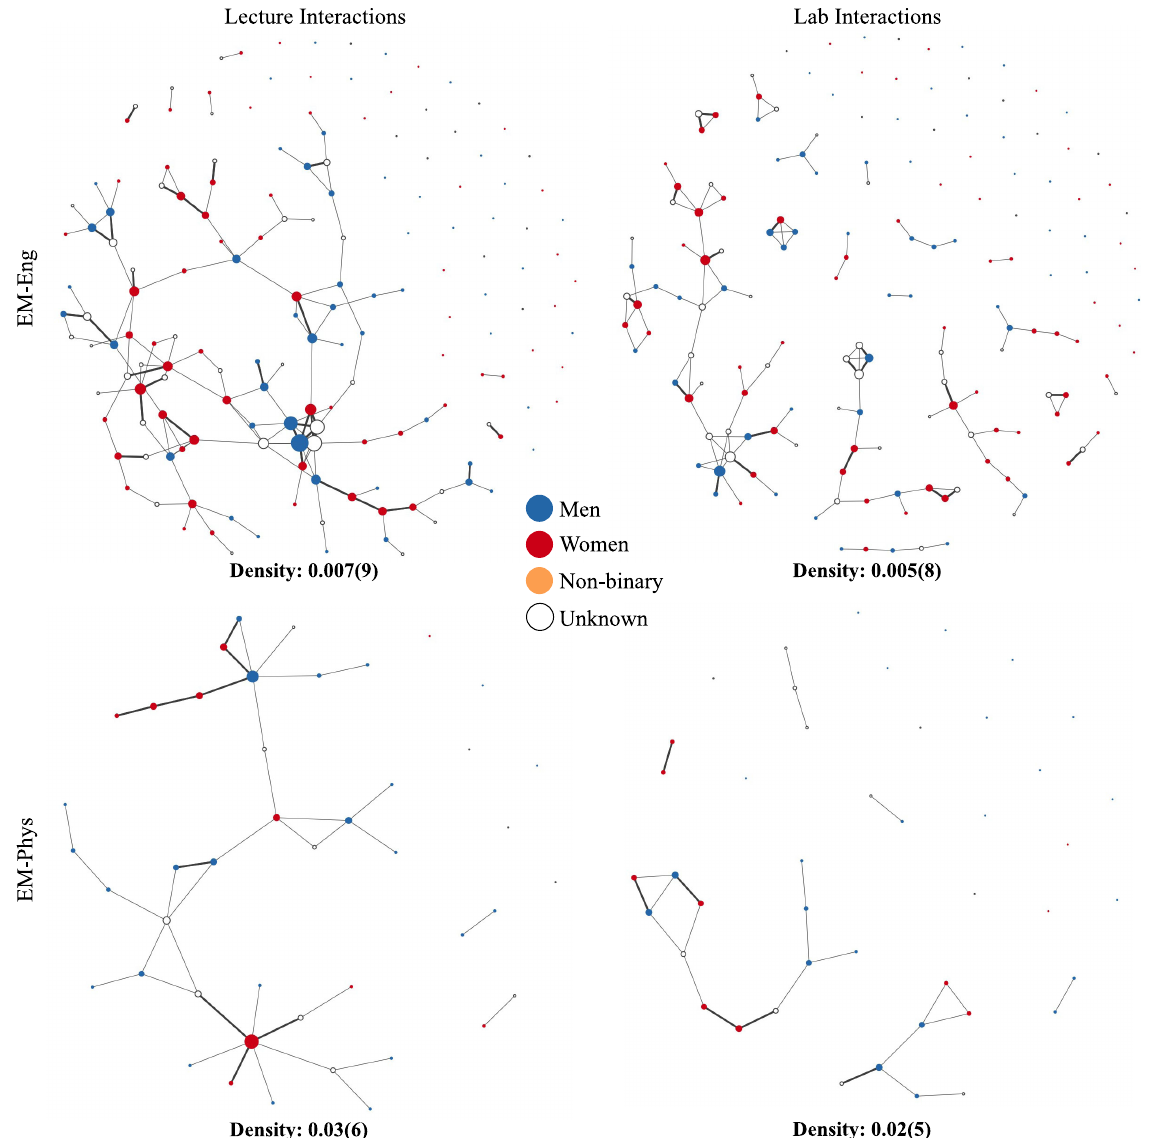
FIG. 3. Diagrams and densities of interaction networks for EM-Eng and EM-Phys. Nodes are colored by gender and sized proportional to total degree (number of adjacent edges). Thick edges represent reciprocal edges (students A and B both reported interacting with one another) and thin edges represent one-way edges (student A reported interacting with student B, but student B did not report interacting with student A). Densities are the proportion of observed to possible edges, with standard errors of the last digit shown in parentheses. These same network diagrams with nodes colored by race or ethnicity are in the Supplemental Material